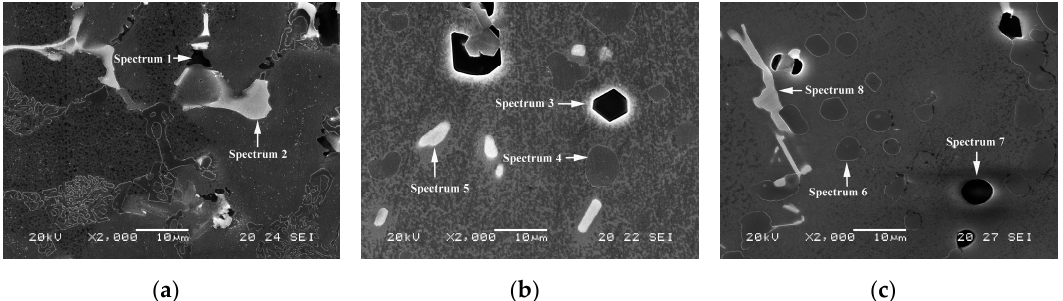
ageing at 170 ◦ C for 24 h.